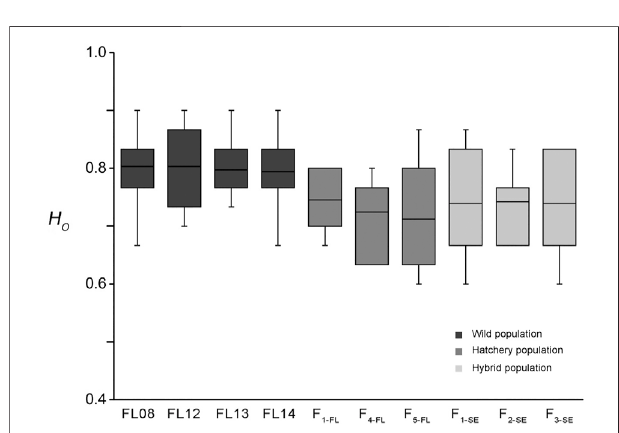
FIGURE 2 | The box plot of H O values of wild (FL08, FL12, FL13, and FL14), hatchery (F 1-FL , F 4-FL , and F 5-FL ) and “ enhancement stock ” strains (F 1- SE , F 2-SE , and F 3-SE ) of lined